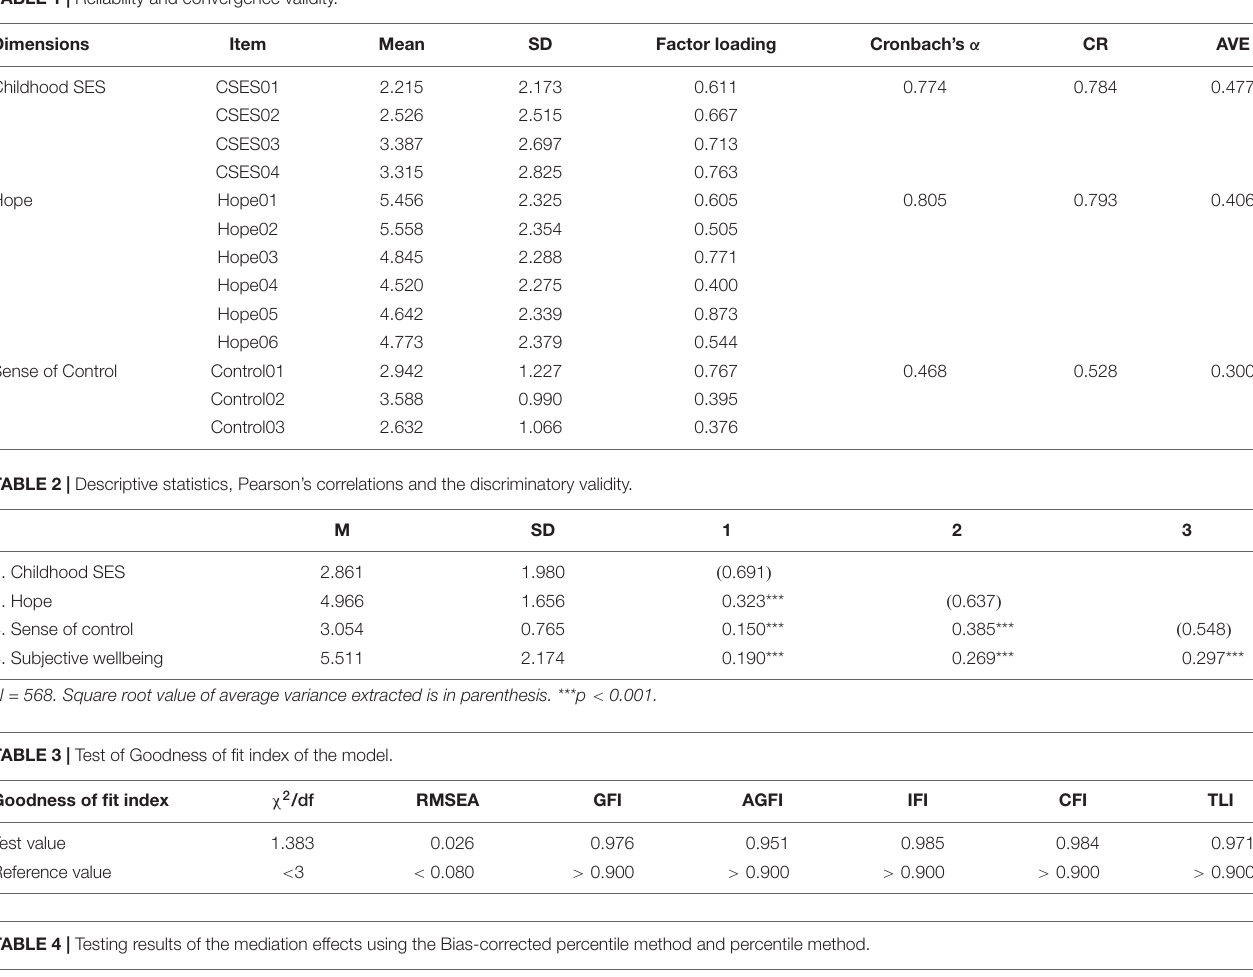
TABLE 1 | Reliability and convergence validity.